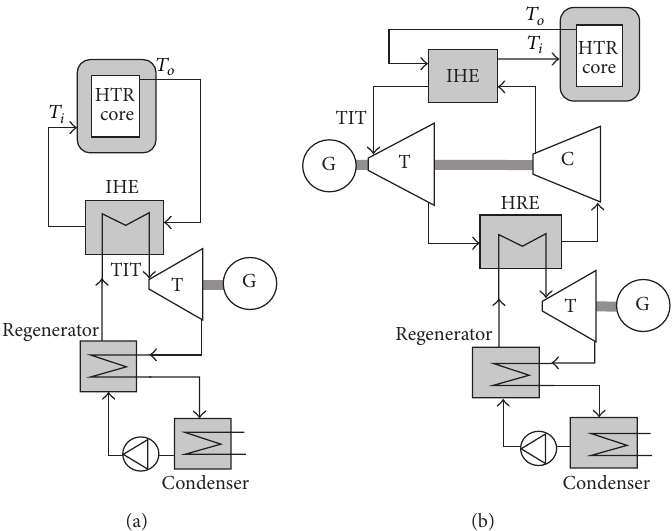
Figure 2: Flow diagrams of the proposed GT-MHR cycles’ structure based on helium cooled gas reactor [14].